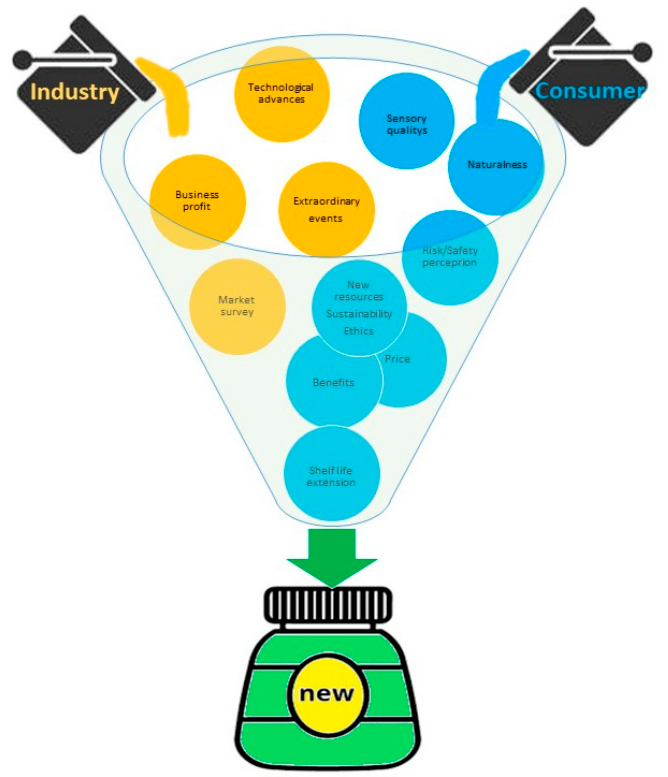
Figure 1. The food product development (NPD) from the perspective of the consumers (blue) and the industry (yellow). the industry